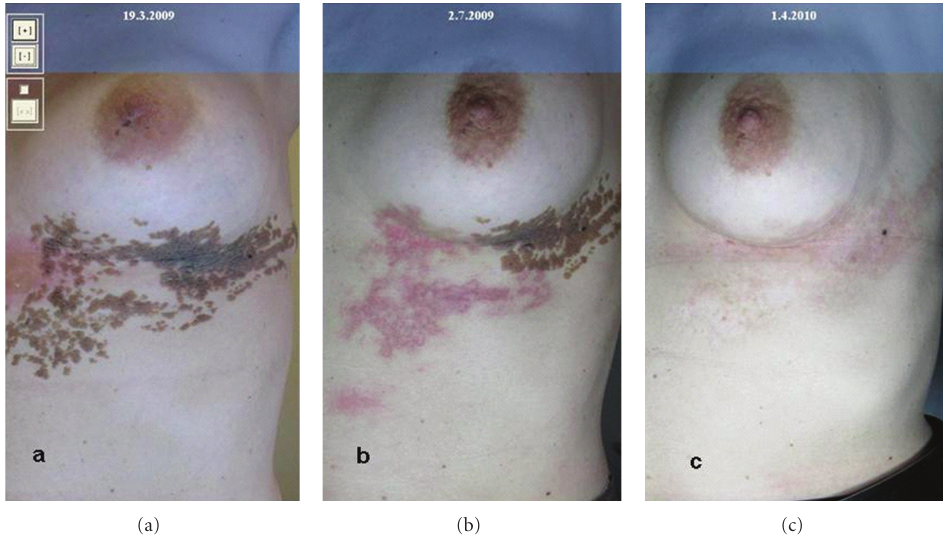
Figure 3: N. E. V. I. L. at first (a) and after three (b) and six (c) treatments with CO 2 laser.